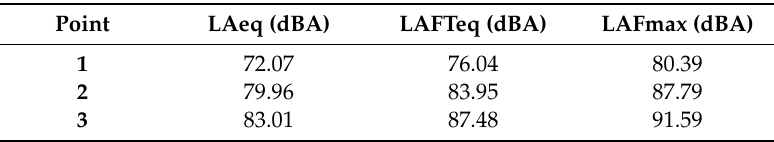
Table 3. Measures from outside sonometers.